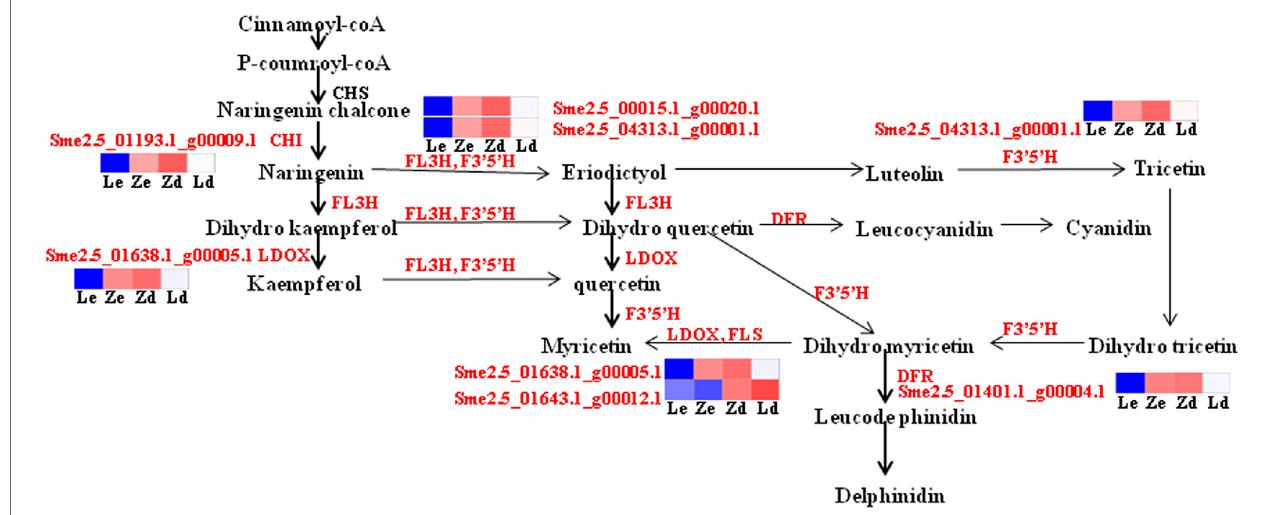
FIGURE8| Detailedanalysisof fl avonoidbiosynthesispathwaysinvolvedineggplantfruitskincolorbasedontranscriptomedata.LdandZd,samplesfromthefruit apex, and Le and Ze, samples from under the calyx of L and Z line eggplants, respectively. Blue means down-regulated, red means